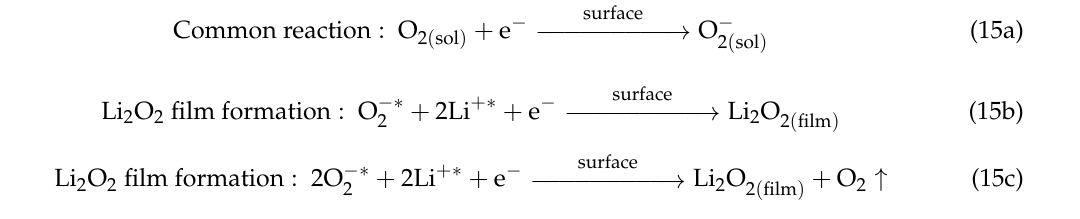
Figure 15. Pore size distribution of Super P and Ketjen Black carbons, with parameters in the bimodal distribution function. Republished from Xue et al. [23] with permission of The Electrochemical Society, conveyed through Copyright Clearance Center, Inc.